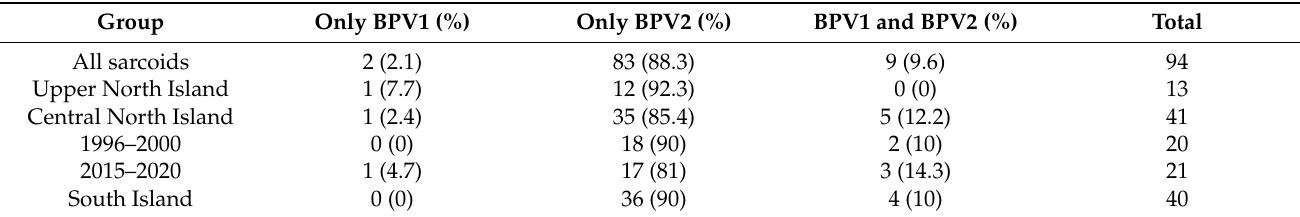
Table 3. Summary of the type of bovine papillomavirus (BPV) detected in the equine sarcoids. This table only includes those sarcoids that were found to contain papillomavirus DNA. Group Only BPV1 (%) Only BPV2 (%) BPV1 and BPV2 (%) Total All sarcoids 2 (2.1) 83 (88.3) 9 (9.6) 94 Upper North Island 1 (7.7) 12 (92.3) 0 (0) 13 Central North Island 1 (2.4) 35 (85.4) 5 (12.2) 41 1996–2000 0 (0) 18 (90) 2 (10) 20 1 (4.7) 17 (81) 3 (14.3) 21 South Island 0 (0) 36 (90) 4 (10)